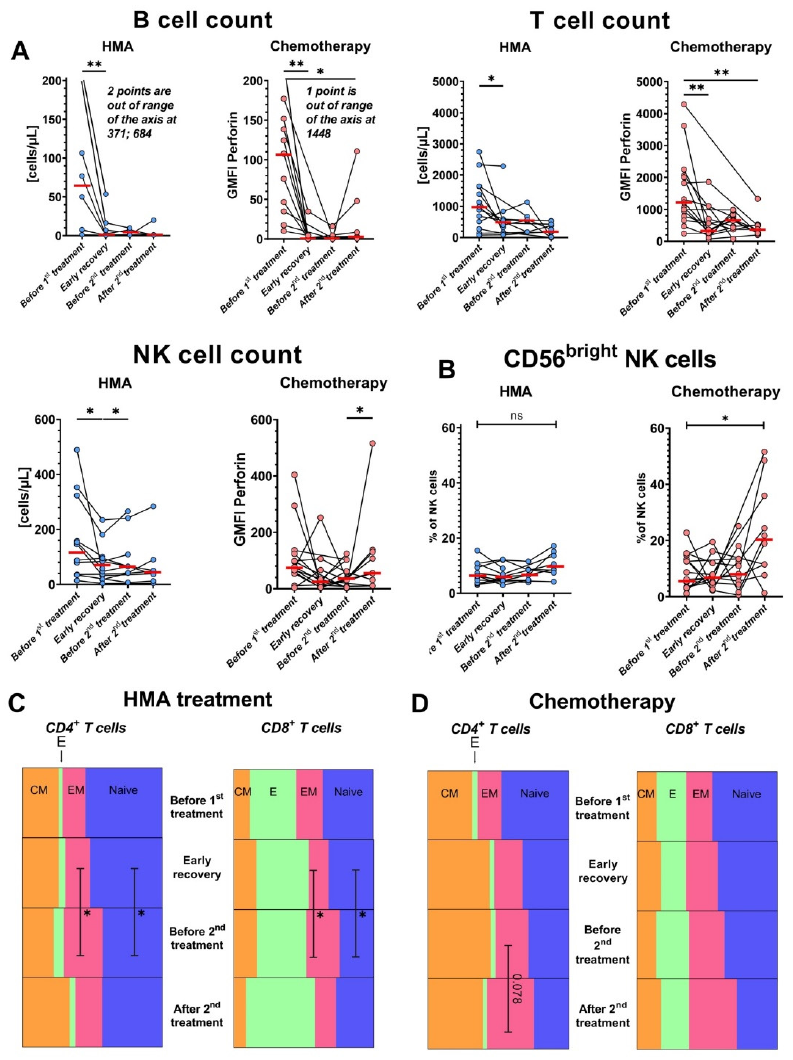
Figure 3. Both treatments deplete lymphocytes, and HMA/venetoclax therapy shifts T cells toward the effector memory phenotype. AML patients with >1 sample collected were divided into two groups based on the treatment scheme: (1) combination of HMA/venetoclax (“HMA”, blue circles) and (2) IC (“Chemotherapy”, pink circles). Red bars represent medians. ( A ) Changes in absolute numbers of lymphocytic populations over the course of treatments. ( B ) Percentage of immature CD56 bright NK cells among total NK cells during the courses of treatment with HMA (left) or IC (right). ( C ) Parts-of-whole diagrams showing changes in the median proportions of CD4 + (left) and CD8 + (right) T cells during the HMA treatment course. T cell subsets are: CM—central memory (orange), E—effector (green), EM—effector memory (pink), naïve (blue). Rows show timepoints from the top (“before treatment”) to the bottom (“after treatment”). ( D ) As in panel C, part-of-whole diagram showing changes in the proportion of T cell subsets during the course of intensive chemo- therapy. Wilcoxon signed-rank test was used for statistical analysis. ns— p > 0.05; *— p < 0.05; **— p <